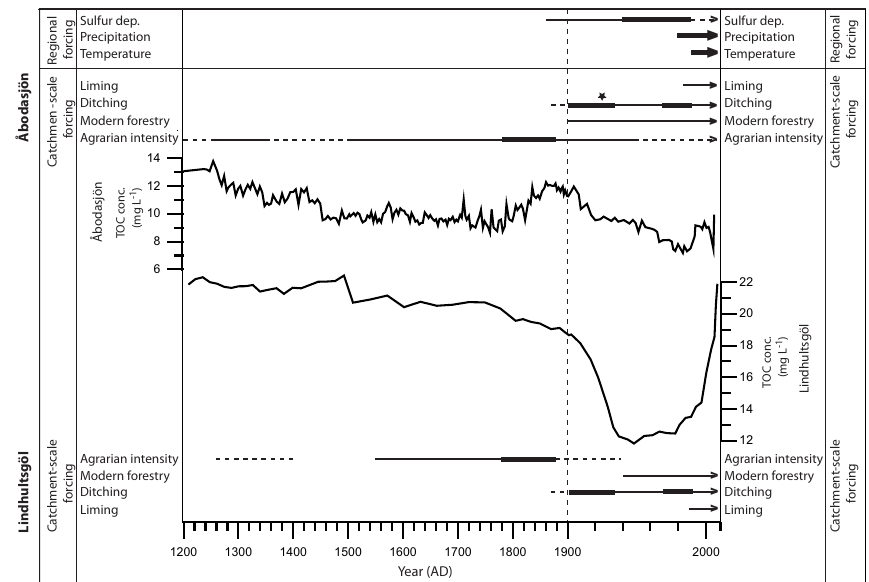
Figure 5. Records of VNIRS-inferred lake-water total organic carbon (TOC) concentration from Åbodasjön (upper graph) and Lindhultsgöl (lower graph) in the perspective of possible regional and catchment-scale forcings of TOC changes. Regional forcings include sulfur depo- sition, precipitation and temperature (Fig. 3). Local forcings include site-specific liming history, regional trends in ditching (Hånell, 2009) and changes in land use inferred from pollen data (Fig. 2) and historical accounts (agrarian intensity and modern forestry). Horizontal lines represent periods of activity, thick lines represent periods of increase or high intensity, and dashed lines represent periods of decrease or low intensity. Arrows indicate ongoing processes. The star marks a major drainage effort undertaken at the inlet of Åbodasjön in AD1922. The vertical dashed lines represent AD1900. Note the different scale for the period